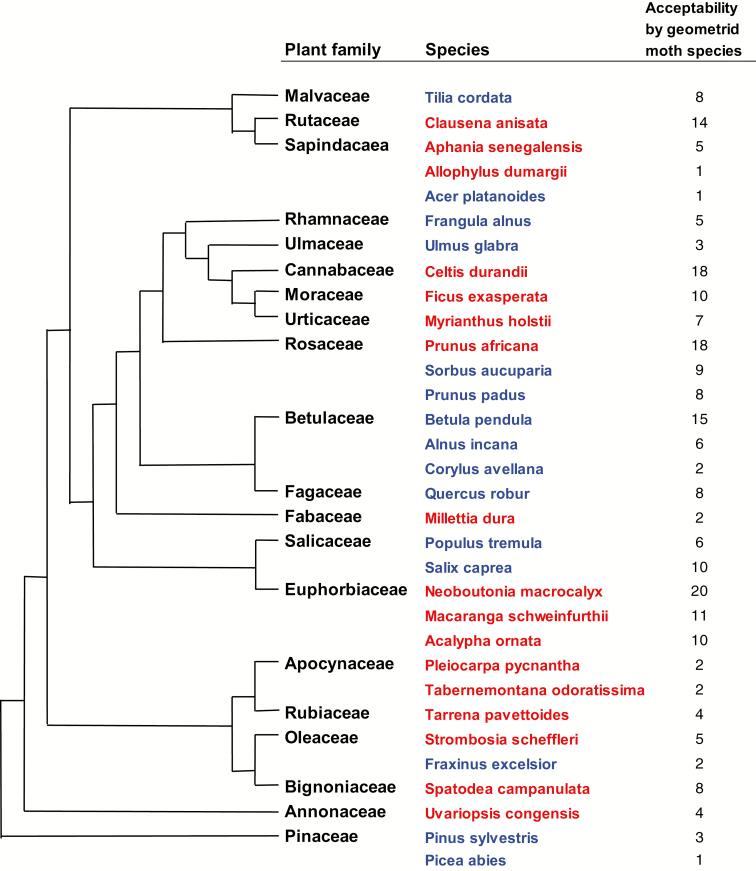
Cladogram of the plant families (modified from Song et al. 2016) and species used in this study. Species from the tropical region are marked in red, species from the temperate region are in blue.